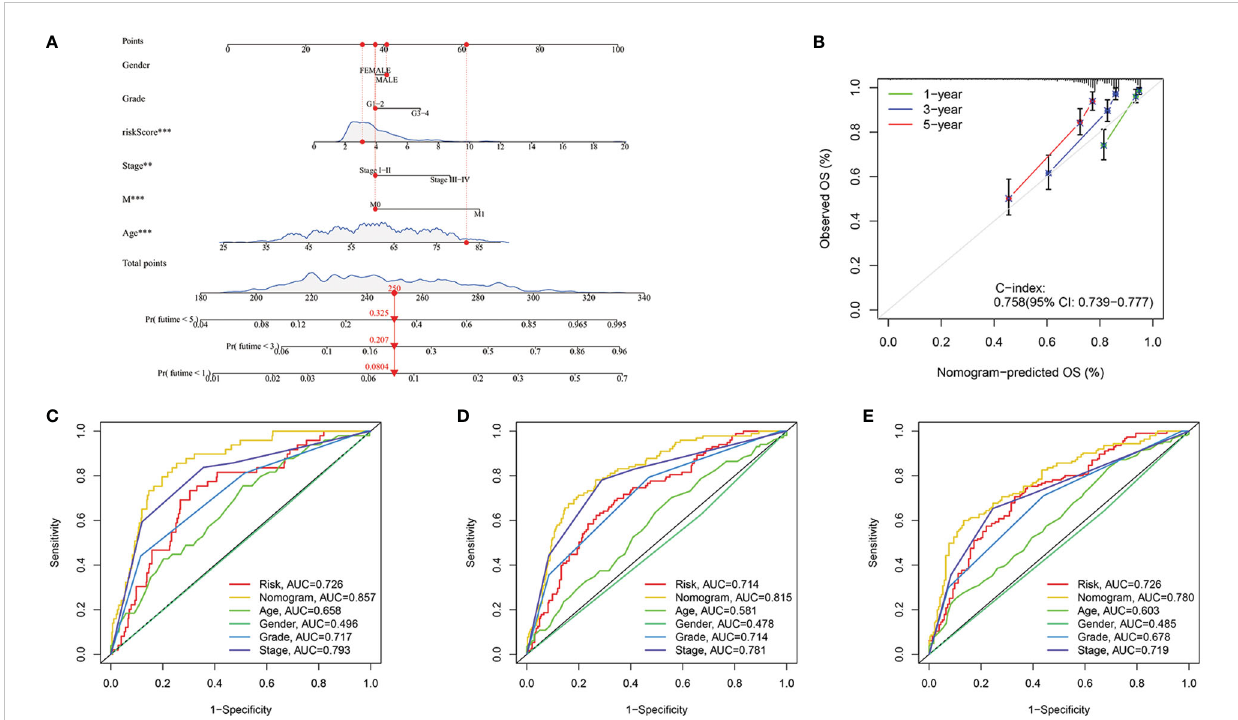
FIGURE 9 Construction of the nomogram. (A) Nomogram to predict the probability of mortality at 1, 3, and 5 years. (B) The C-index of the nomogram. (C – E) ROC curve of the nomogram in 1, 3 and 5 years were 0.857, 0.815 and 0.780 respectively. **p<0.01,